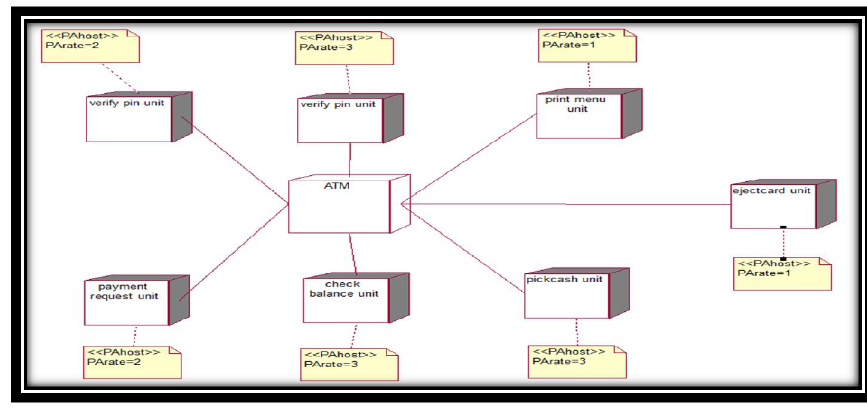
Fig. 6. Deployment Diagram for ATM